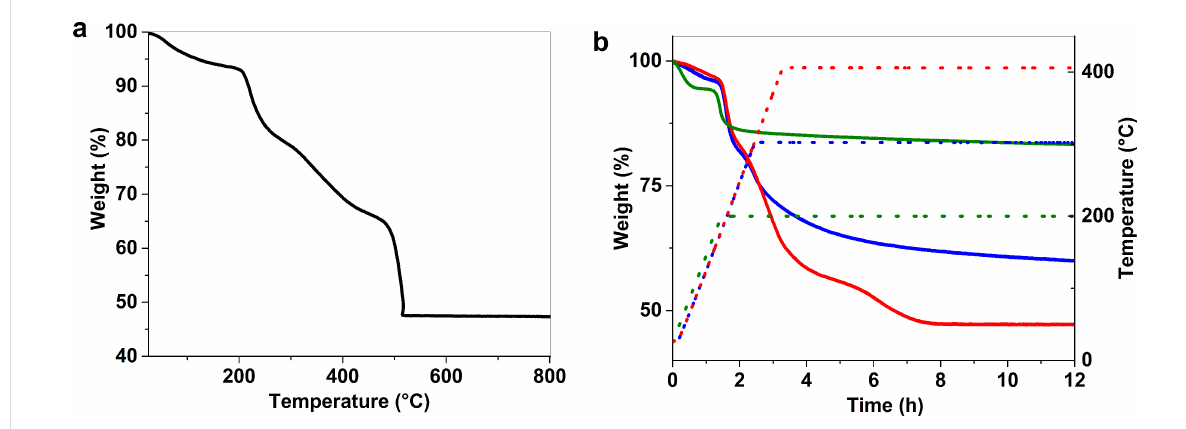
Figure 1: (a) TGA experiment on Au 25 (SG) 18 under air at 10 °C/min. (b) Isotherm experiments on Au 25 (SG) 18 under air at 200 °C (green), 300 °C (blue) and 400 °C (red) for 12 h. Solid lines represent the weight (%) and dotted lines represent the heating ramp.